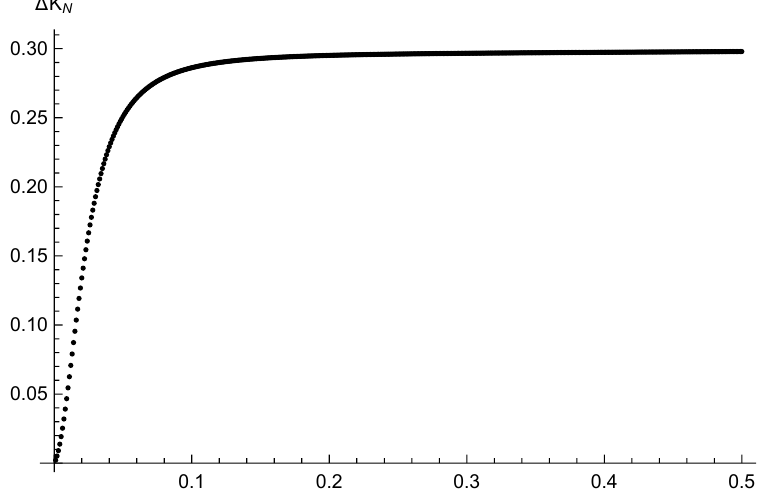
Figure 15. ∆ K N as a function of λ , considering H 3 and the initial conditions I.